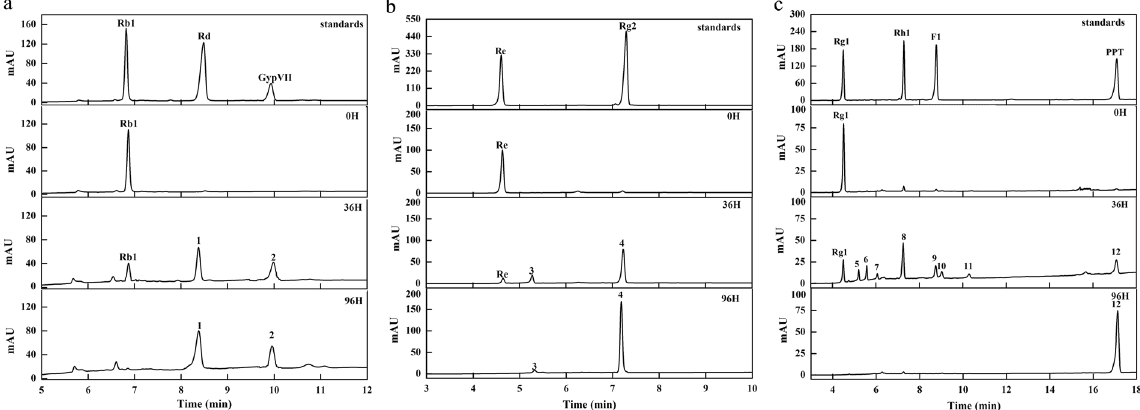
Figure 1. HPLC analysis of ginsenoside Rb1 ( a ), Re ( b ), and Re ( c ) during biotransformation process by using Cellulosimicrobium sp. TH-20.